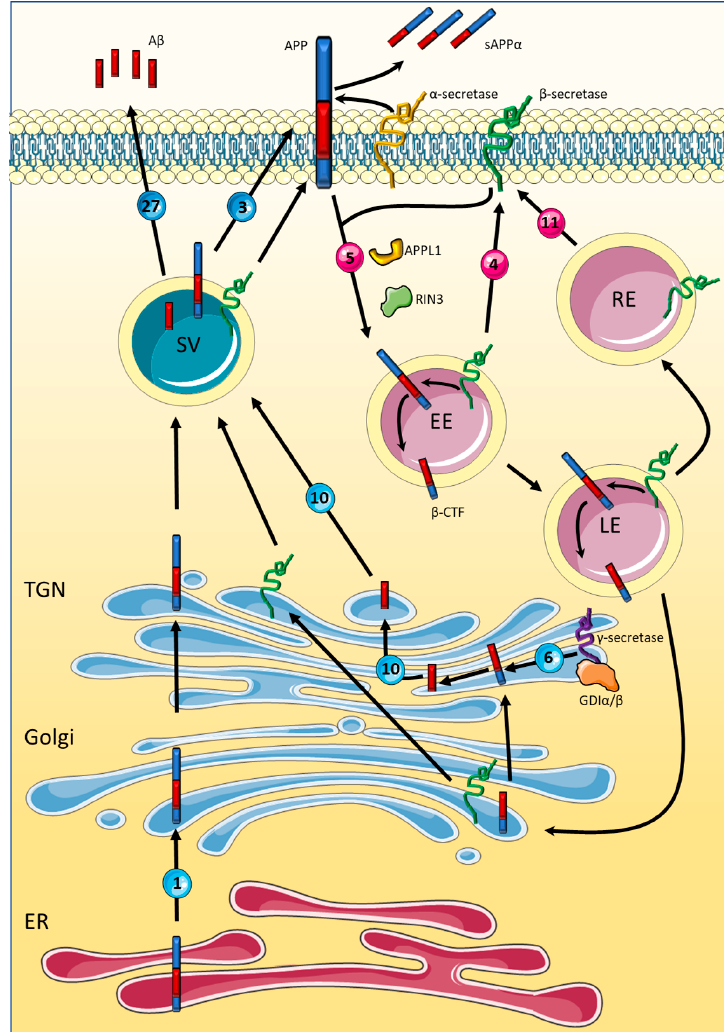
Figure 3. Rab-mediated amyloid precursor protein metabolism. De novo amyloid precursor protein (APP) is produced with the endoplasmic reticulum (ER) and transported to Golgi for protein mat- uration via a Rab1 trafficking pathway. Upon passage through the Golgi and trans-Golgi network (TGN), APP resides with the plasma membranes. APP may be processed via the non-amyloidogenic route via α -secretase producing soluble APP α which is released into the extracellular environment.